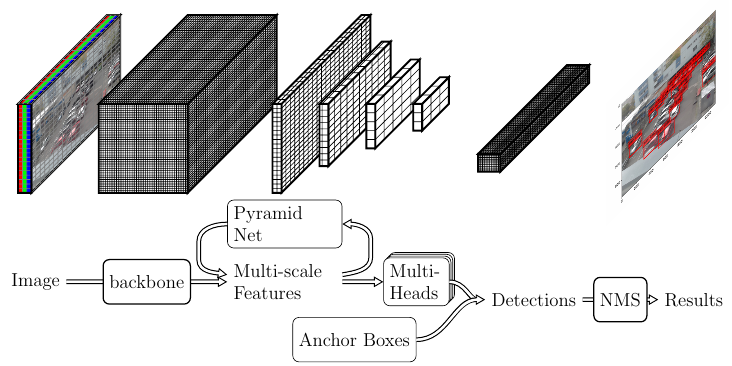
Figure 2. Meta architecture of one stage deep Convolutional Neural Network (CNN) based object recognition. ( Top ): Tensor data representation in different steps. ( Below ): Submodules and processing steps, see text for more details.